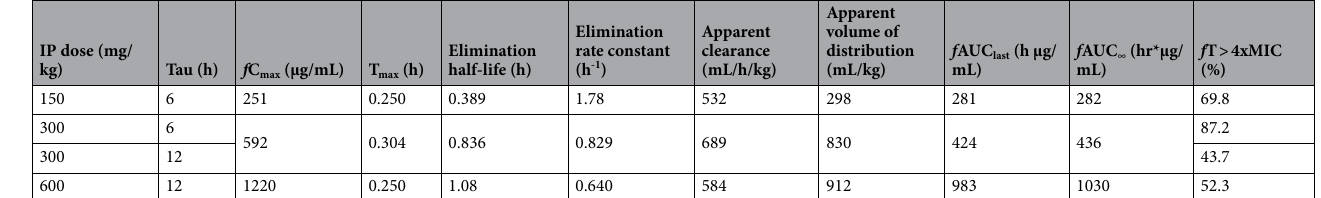
Table 5. Murine pharmacokinetic parameters. The pharmacokinetic parameters of a single dose of ceftazidime at 150 mg/kg, 300 mg/kg, and 600 mg/kg 24 h following aerosol exposure to B. pseudomallei . QID dosing regimens resulted in greater PK/PD drivers of 87.2% and 69.8% f T > 4 µg/mL for the 300 and 150 mg/kg QID regimens, respectively. Lower PK/PD drivers of 52.3% and 43.7% f T > 4 µg/mL were estimated for the 600 and 300 mg/kg BID dosing regimens, respectively. IP